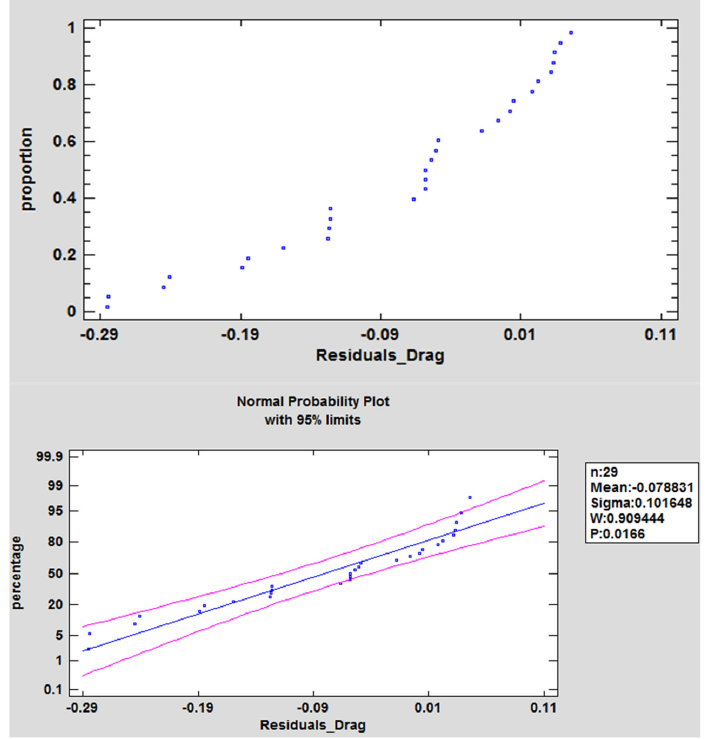
Figure 22. Analysis of the drag forces’ residual values between the wind tunnel and model data.